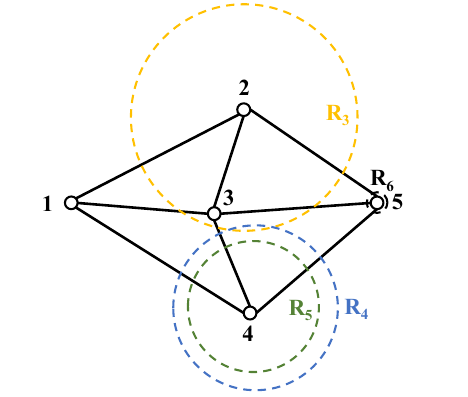
Table 4 All possible paths to each node and the corresponding cost Destination Possible path Crisp cost